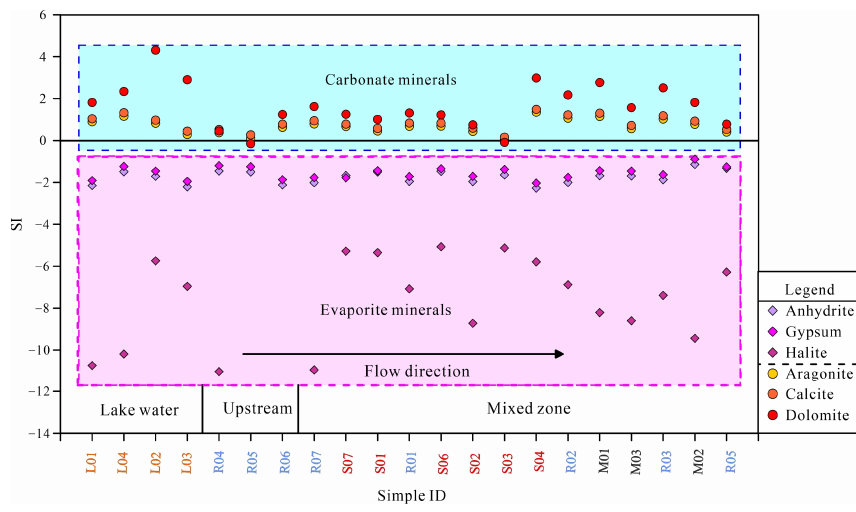
Figure 6. Saturation index (SI) of potentially relevant minerals for the water samples in the study area.